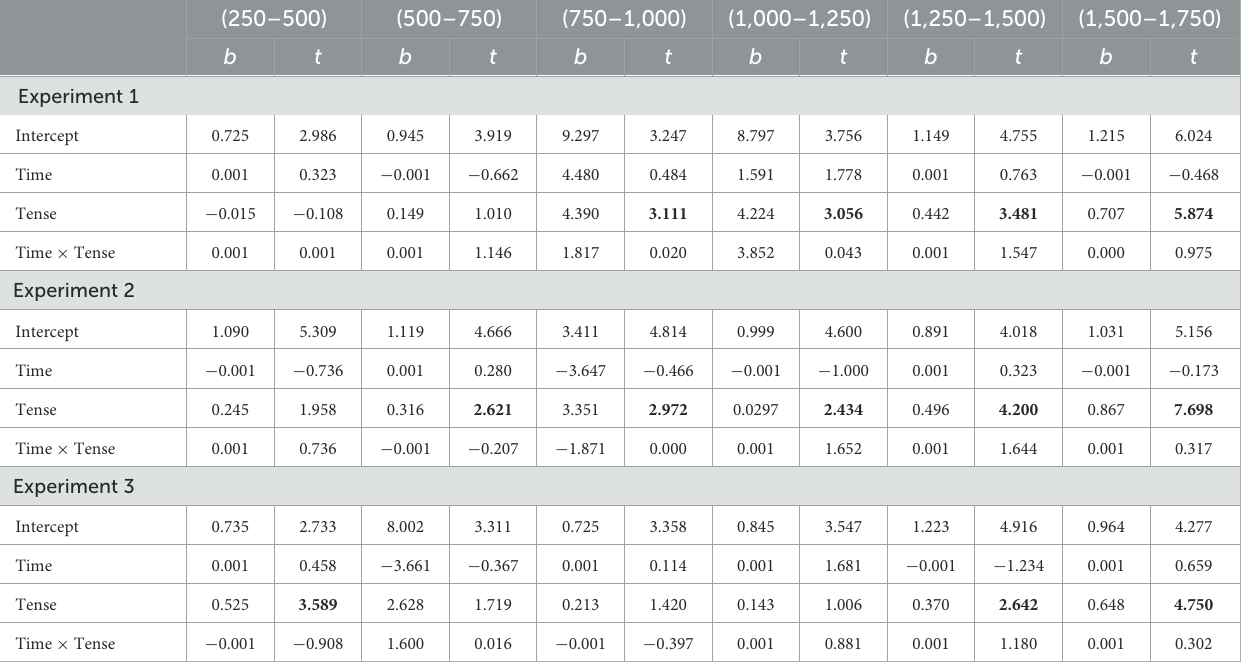
TABLE 2 Fixed effects of the models predicting the inspections of the recent